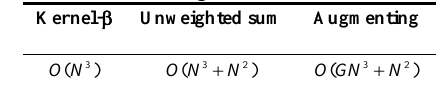
Table 1. Computational complexity of the proposed